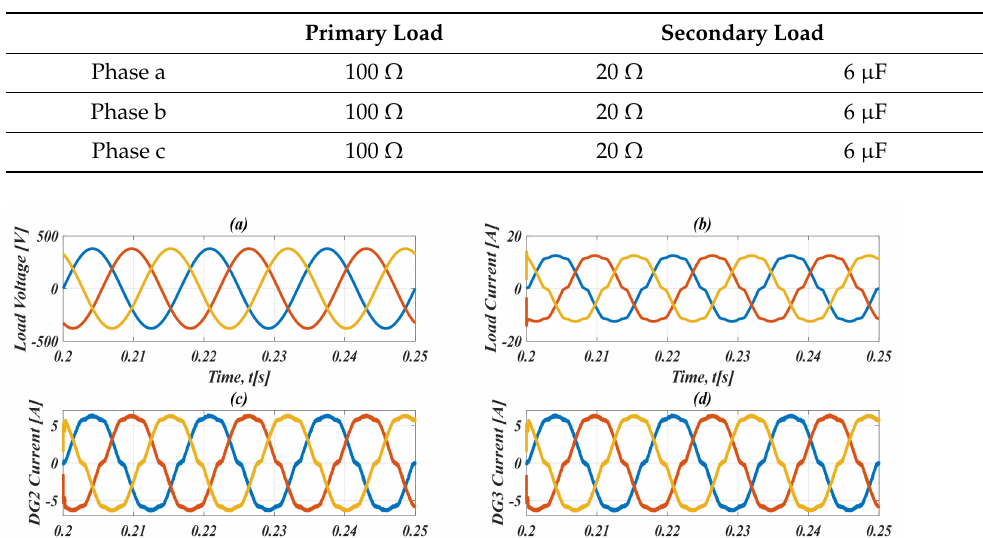
Table 5. Nonlinear Load Parameters.